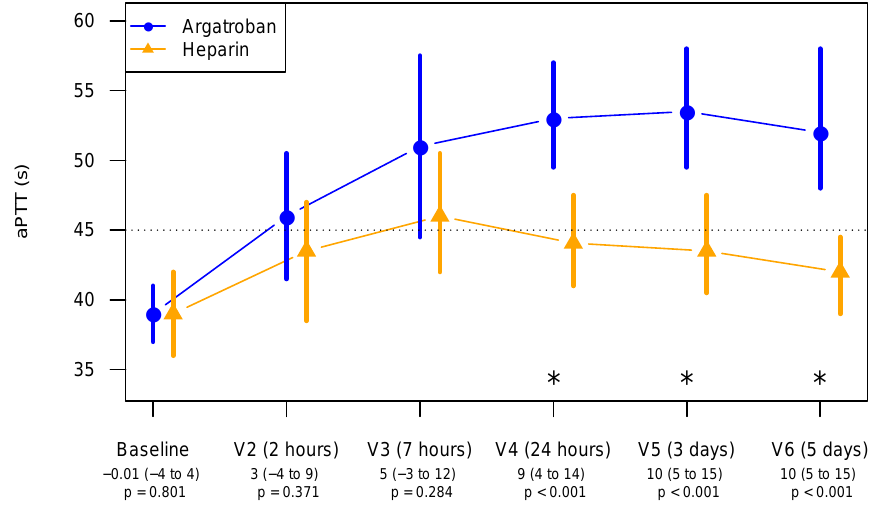
Figure 3. Median aPTT (95% CIs) during the study treatment from Baseline to Visit 6 (day 5) The dotted line at an aPTT of 45 s represents the targeted aPTT. Values below the visit labels indicate the estimated di ff erences with 95% CIs between the aPTT for the argatroban and the heparin group. V indicates the study visits at pre-defined time